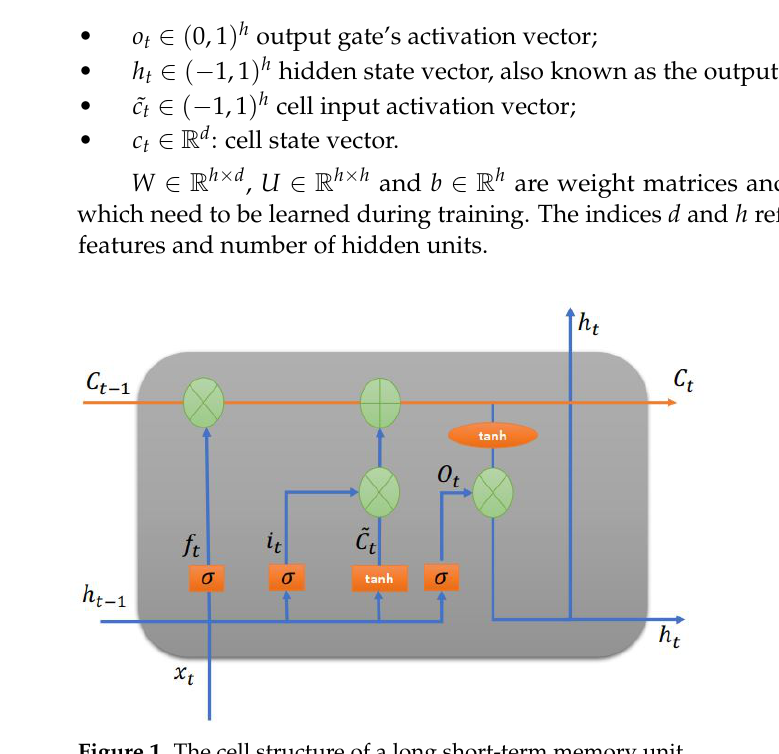
Figure 1. The cell structure of a long short-term memory